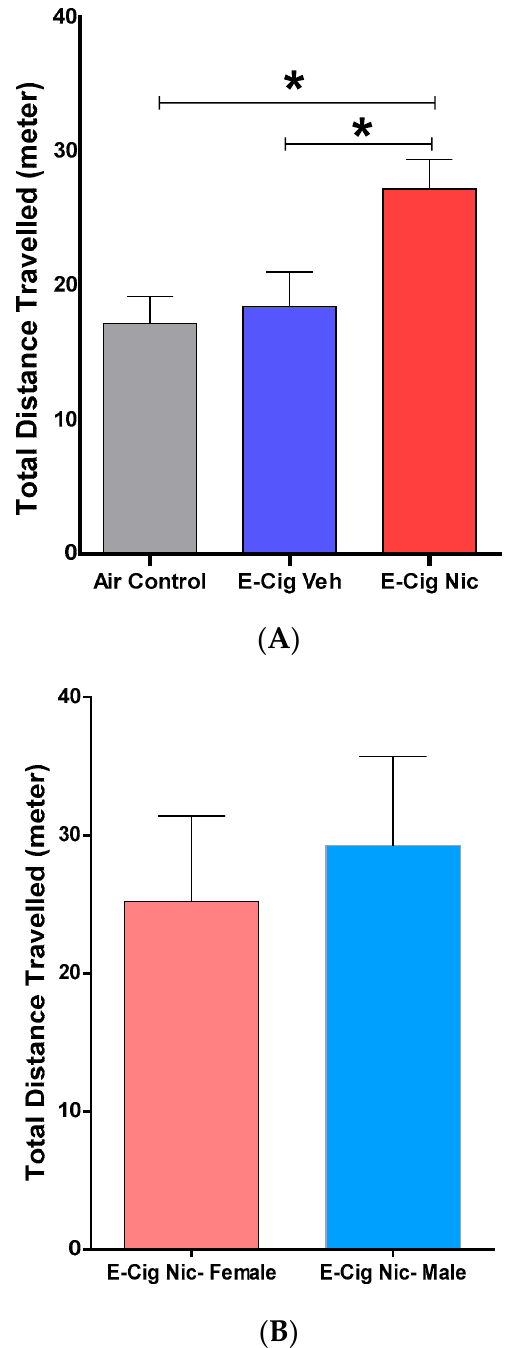
Figure 5. Locomotion-related behaviors following four-week inhalation of e-cigarette vapors con- taining nicotine. ( A ) Total distance traveled for each group (n = 8/group, 4F and 4M). One-way analysis of variance (ANOVA) followed by a Tukey’s post hoc showed a significant increase in the total distance traveled in E-cig Nic group as compared to controls. ( B ) Total distance traveled for female and male mice in the E-cig Nic group (n = 4/group). (* p < 0.05). Unpaired t test also did not reveal any significant changes in the total distance traveled between male and female of E-cig Nic group. Data are presented as mean ± SEM. E-cig, electronic cigarette; E-cig Veh, electronic cigarette with vehicle only; E-cig Nic, electronic cigarette with nicotine; F, female; M, male;